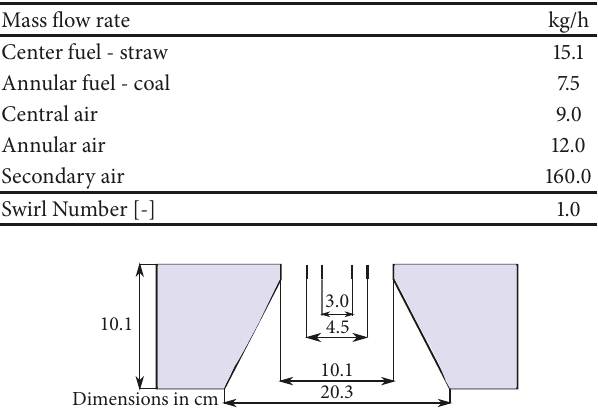
Figure 1: Burner and quarl geometry of the BYU furnace. Coal is fed through the central inlet, biomass through the annular middle inlet, and secondary swirled air through the outer annular inlet. [5].